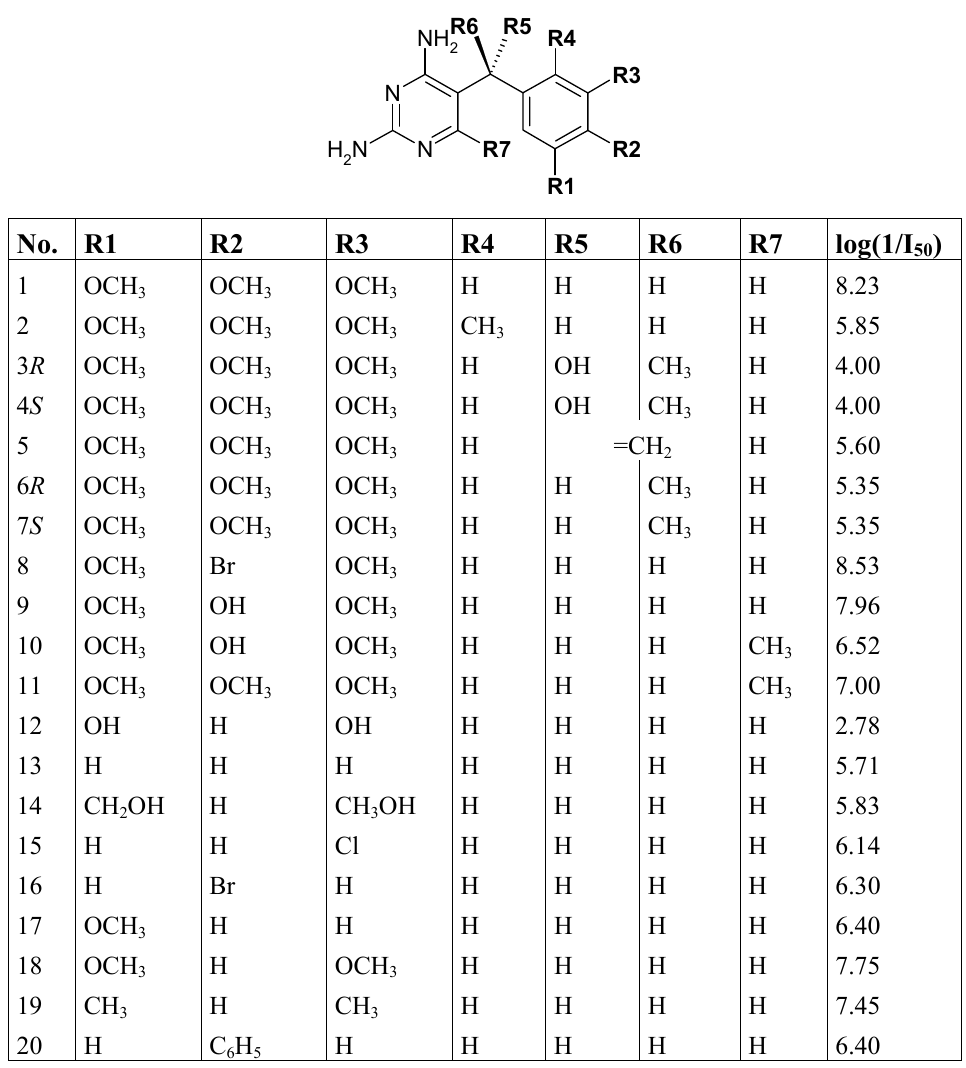
Table 1 . The set of substituted 2,4-diamino-5-benzylpyrimidine inhibitors of Escherichia coli DHFR and their activity data [23].